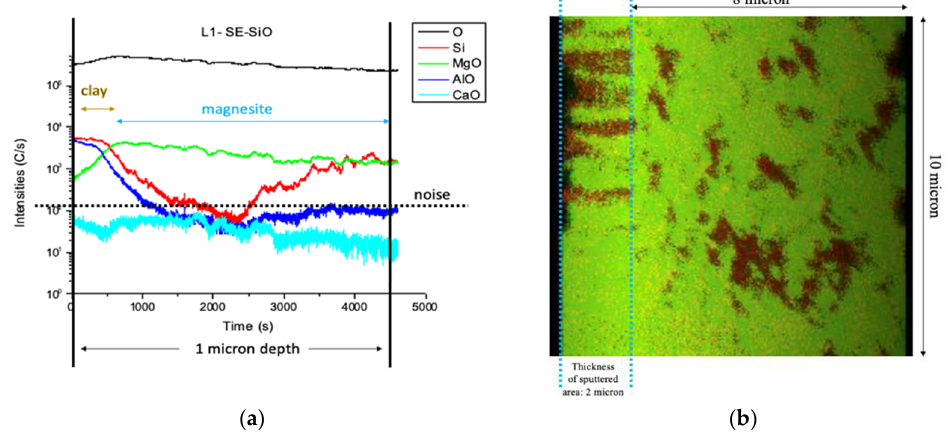
Figure 8. ( a ) A chemical depth profile of 1 micron while sputtering for 4500 s (c. 1.5 h), creating 5000 layers of 0.2 nm showing changes in the chemical composition and the combination of clay minerals and magnesite in a chalk test sample. ( b ) 3D still image from a video created during the sputtering of an area of 8 × 10 micron with a thickness of c. 2 microns. In red, primary calcite and in green, the produced secondary magnesite during flooding experiments for EOR—sample material from a long-term flooding test over 20 months with magnesium chloride in on-shore chalk under reservoir conditions (see [10,12,32]).